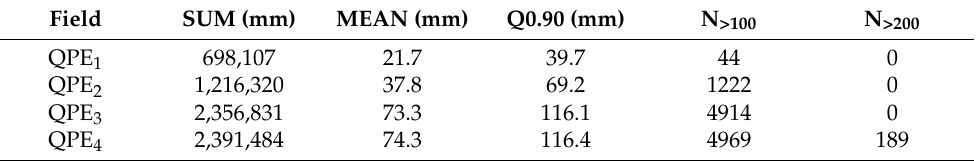
Table 3. Different parameters (from left to right: total sum of rainfall for all pixels 1 × 1 km 2 with precipitation over Catalonia; mean rainfall value for the same set of pixels; 90th percentile; number of pixels with QPE over 100 mm; number of pixels with QPE over 200 mm) obtained for geostatistical analysis of the GeoTIFF files associated with each QPE field for the 22 October 2019